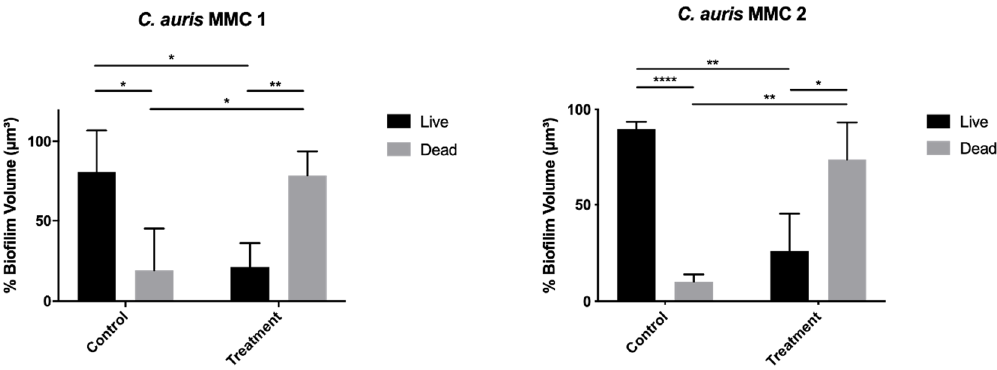
Figure 5. C. auris biofilms were grown for 48 h and treated with 500 µL of NAC-SNO-np (10 mg/mL) for 24 h. Graphs represent averages and standard deviations. Statistical analysis was performed by